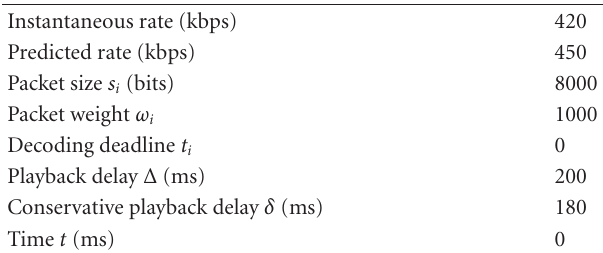
Table 1: Example parameter values for conservative delay schedul-